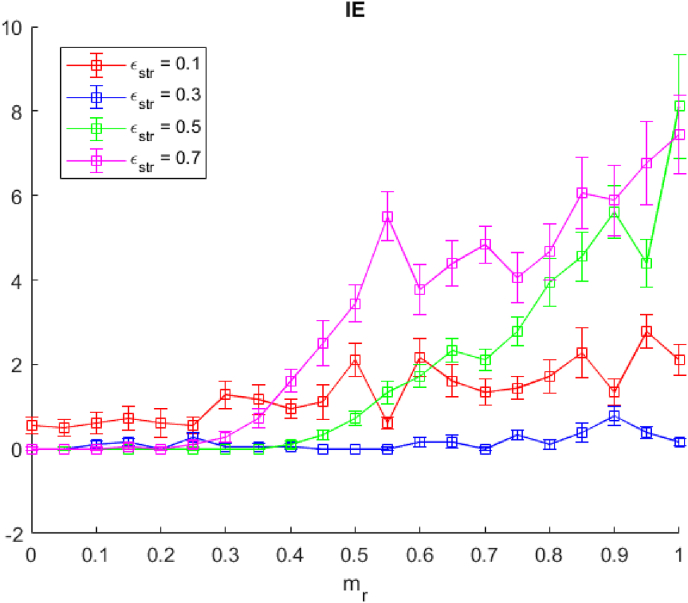
Integration Errors as a function of mr, for four different values of εstr. Error bars show one standard error from the mean.